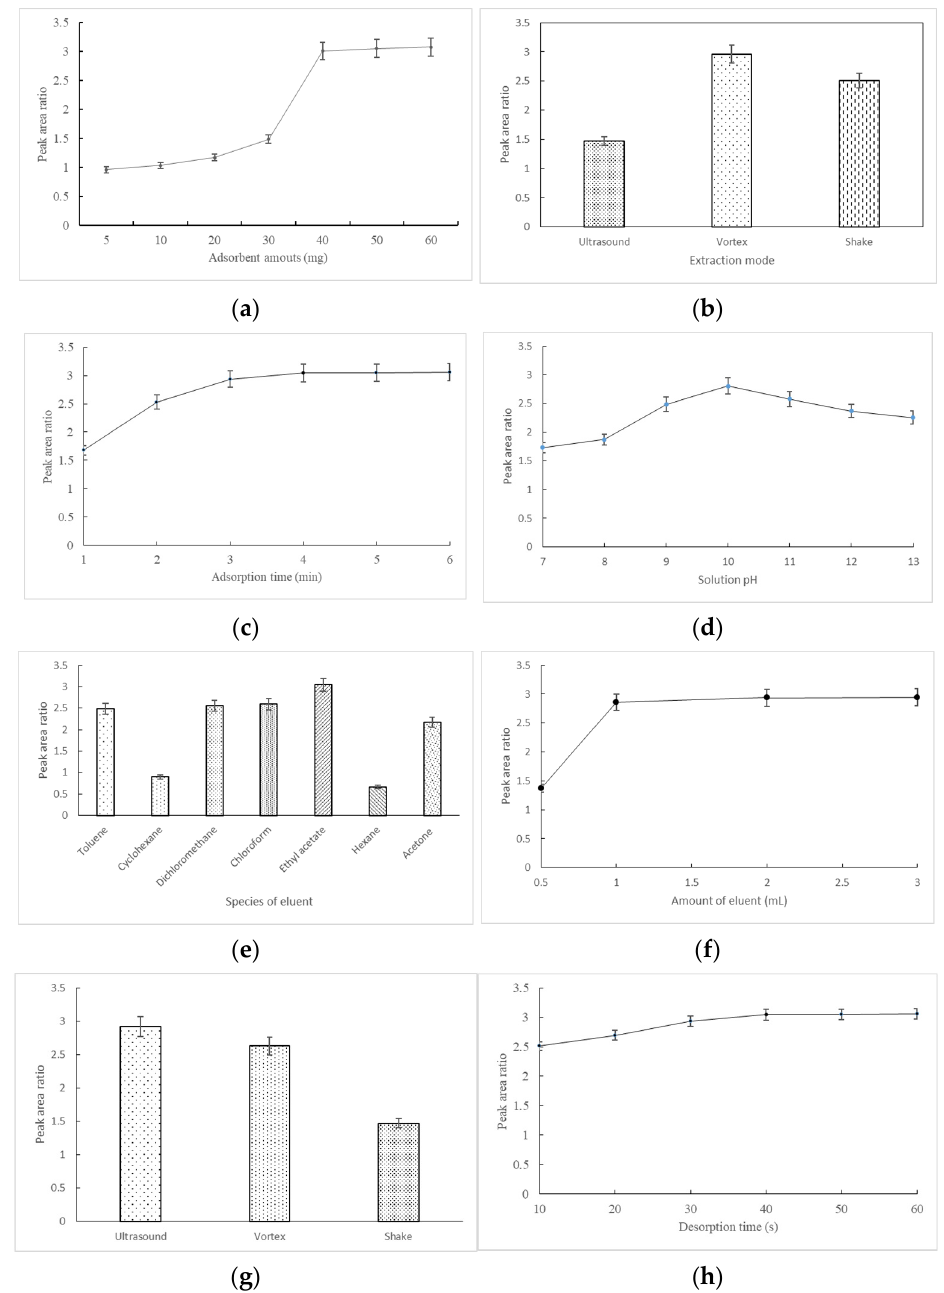
Figure 4. Effects of the amount of extractant ( a ), extraction mode ( b ), adsorption time ( c ), pH of solution ( d ), species of eluent ( e ), amount of eluent ( f ), desorption mode ( g ) and time ( h ) on the extraction efficiency ( n = 3).